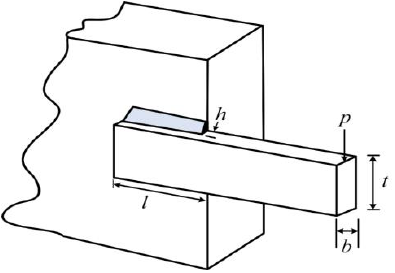
Figure 6. Schematic of the welded beam design problem [101]. Table 9. Comparison of the results obtained for the welded beam design problem.